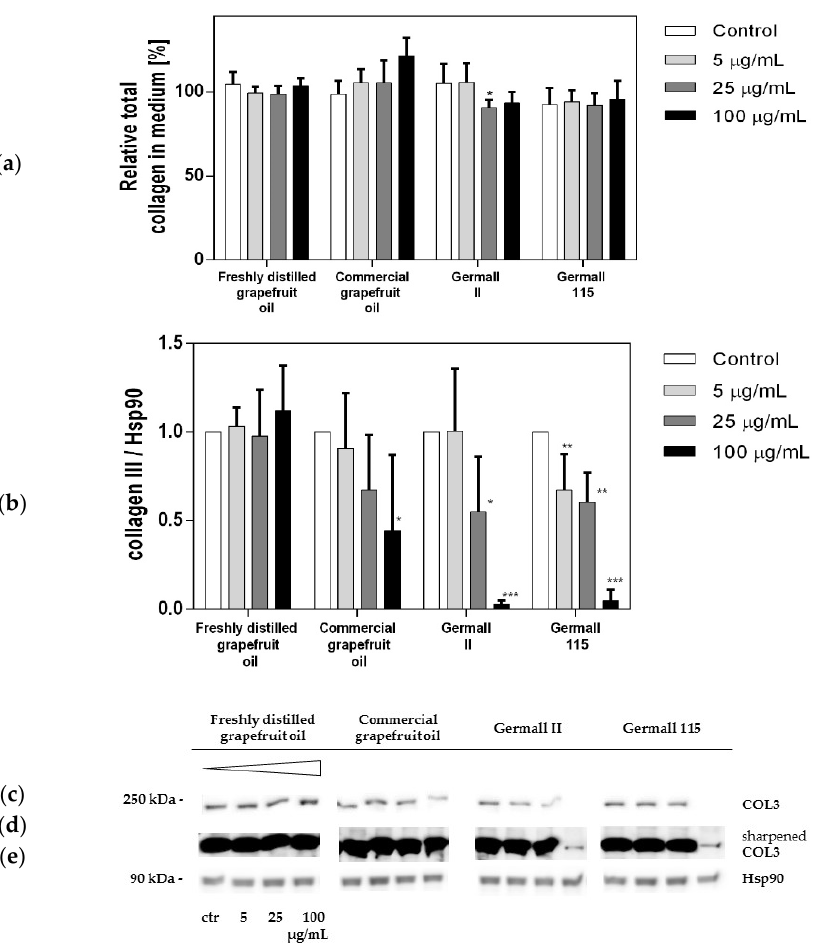
Figure 3. ( a ) Effect of selected preservatives on total content of secreted collagen in BJ cell medium using Sircol dye test. ( b ) Influence of the following compounds on intracellular collagen type III level, assayed by Western blot. ( c ) Level of collagen in BJ cells in each probe on membrane. ( d ) The same membrane as ( c ) but sharpened to visualize the lowest levels of collagen in germall probes. ( e ) Level of Hsp90 used as a control in each probe. Each value (% of control) ± SD represents the result after 24 h incubation of BJ cells with preservatives, repeated 6 times in independent experiments; n = 6, one-way ANOVA. *, p < 0.05; **, p < 0.01; ***, p < 0.001. Table 5. Images of BJ cells after 24 h treatment with selected preservatives. Influence of the highest concentration on viability is observed as changes in structure of BJ cells. Magnification 100×.